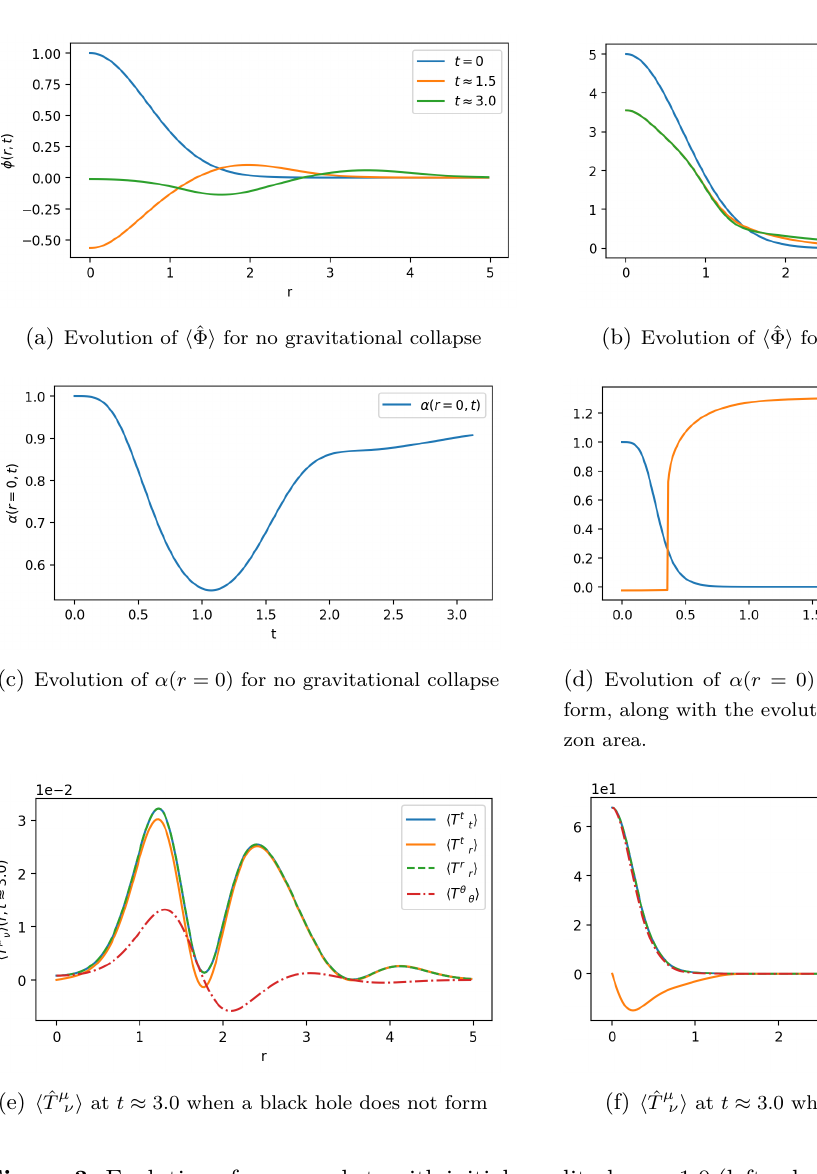
Figure 3 . Evolution of wave-packets with initial amplitude a = 1 . 0 (left column) and a = 5 . 0